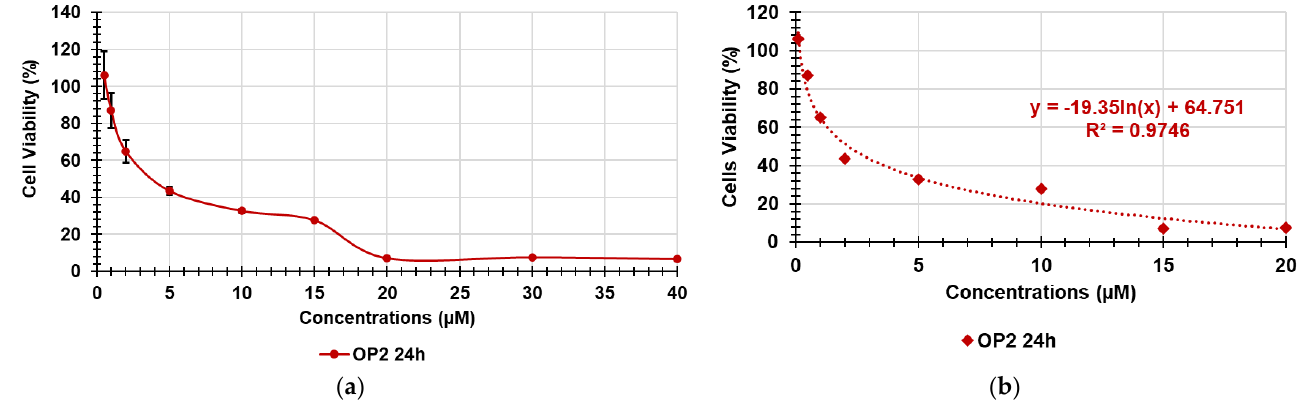
Figure 5. Curve of MAIL-2 cell viability (%) vs. concentrations (0.1 – 40 µM) of OP2 at 24 h ( a ); logarithmic tendency line fitting the dispersion graph shown in Figure 5a (0.1–20 µ M) ( b ). Table 1. Polynomial and logarithmic equations of the tendency lines, R 2 values, LD 50 of CP1 and OP2, as well as the relative SI ranges calculated using Equation